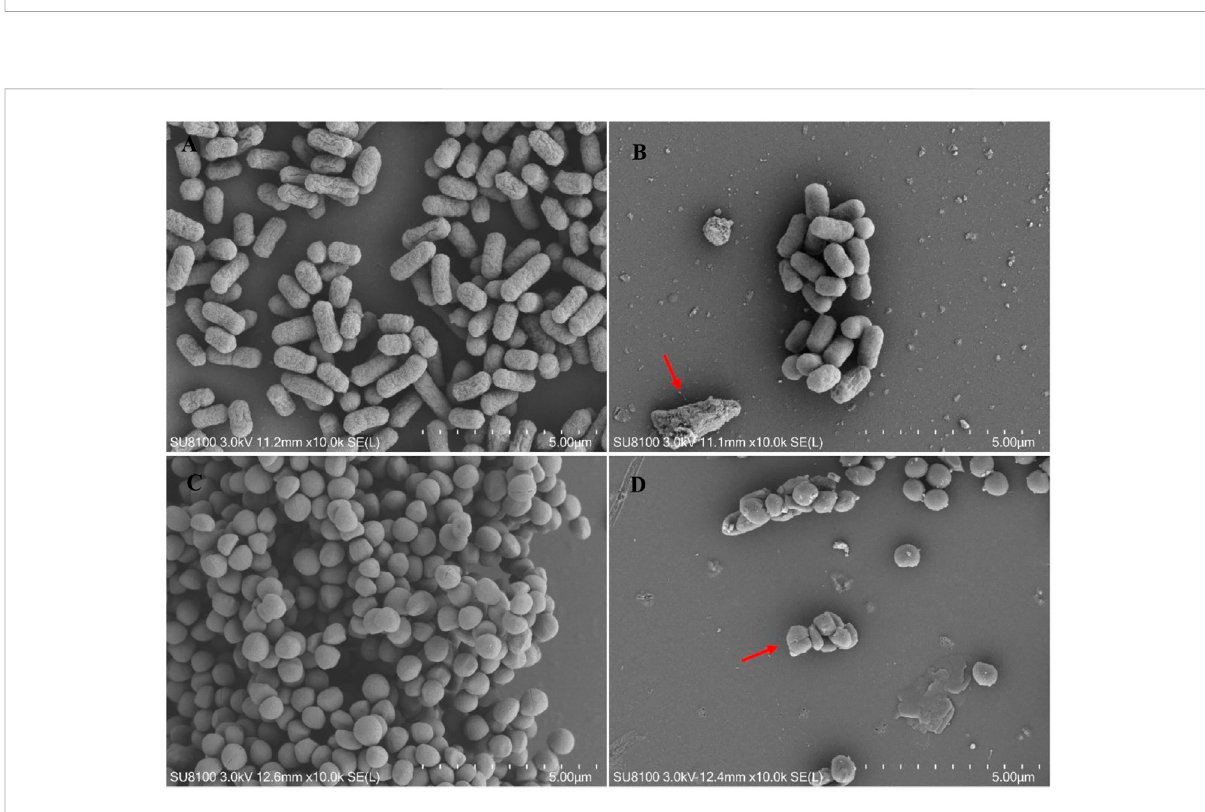
FIGURE 7 Time-killing curves of E. coli (A) and MRSA (B) treated with Lceo-AgNPs at the concentrations of MIC and